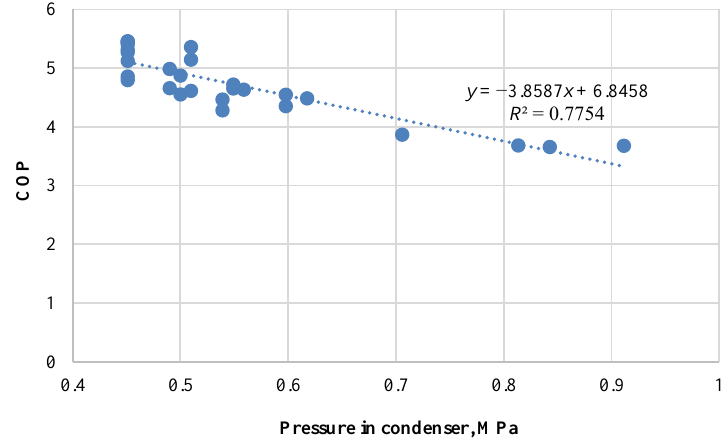
Fig. 8. Single-stage compressor COP depending on condenser